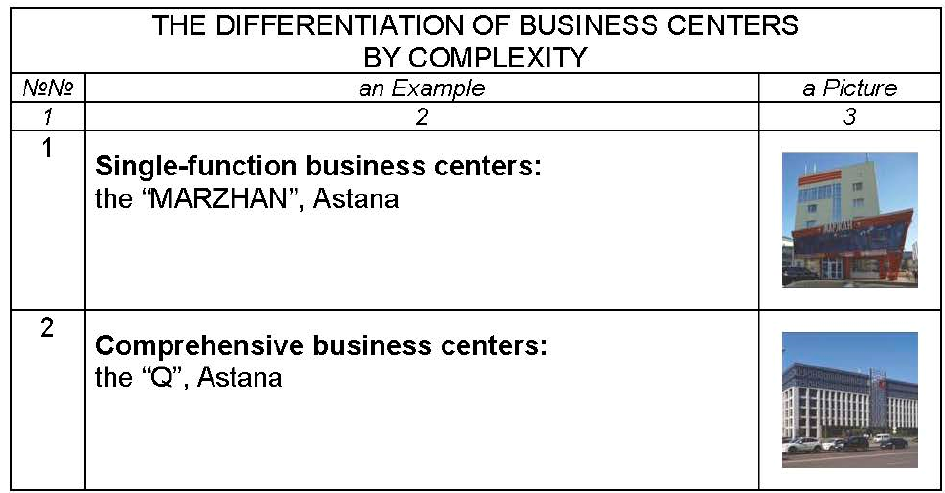
Figure 16. The differentiation of business centers by complexity: ( 1 ) the MARZHAN, Astana [132]; and ( 2 ) the Q, Astana [133].